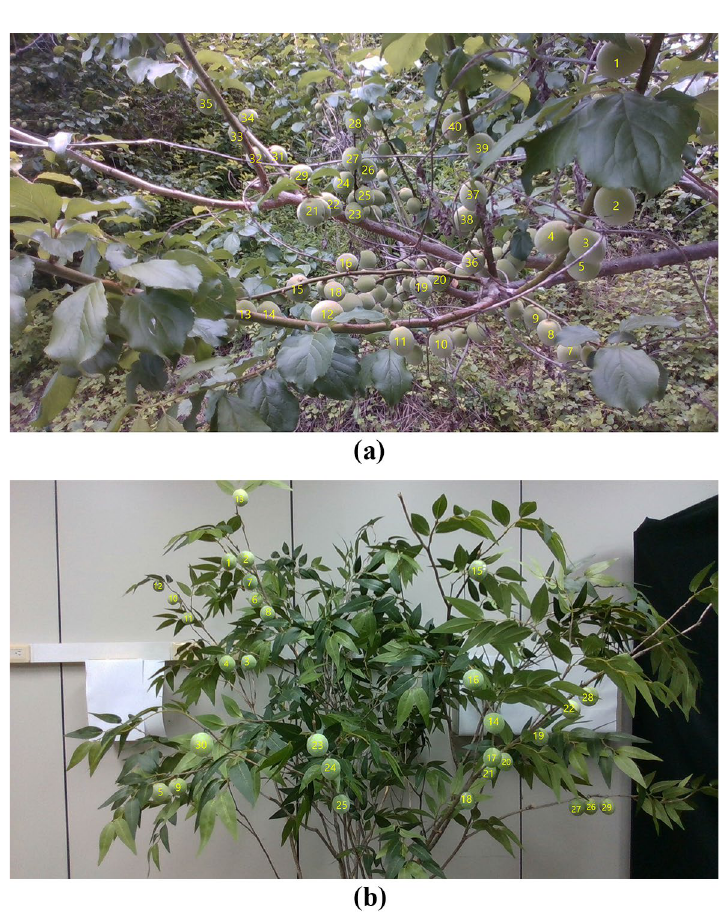
Figure 13. Finding and marking the location of each numbered Prunus mume fruit: ( a ) outdoors; ( b )